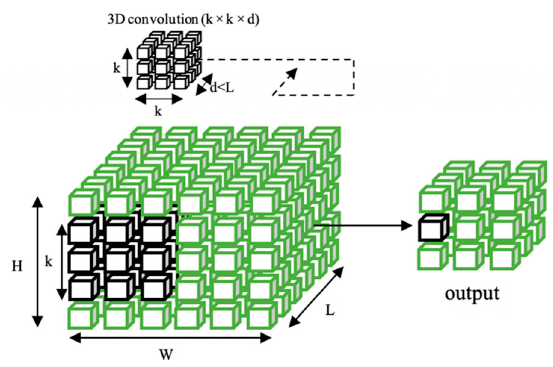
Figure 11. Diagram of a 3D convolution operation [30]. To apply a 3D convolution to a 2D image of size W × H × L (width pixels times height